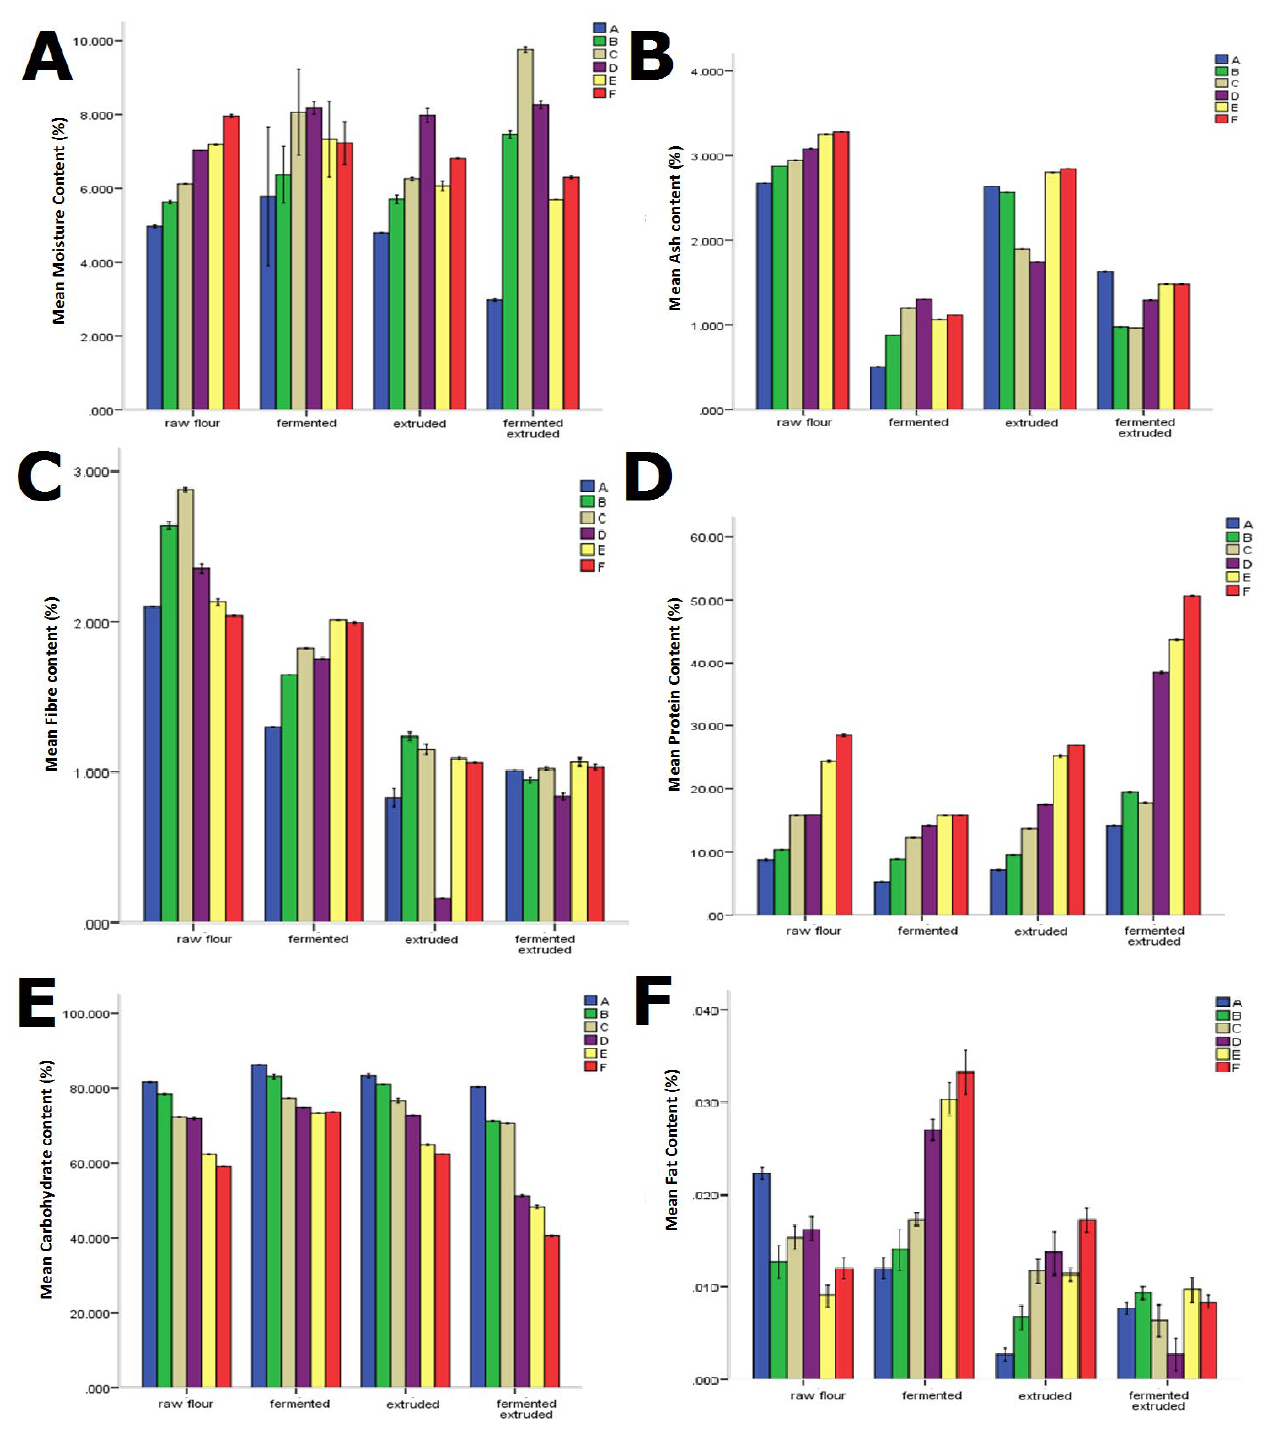
(A) (B) (C) (F) , ash content , fiber content , of Cassava-African yam bean blends. A: